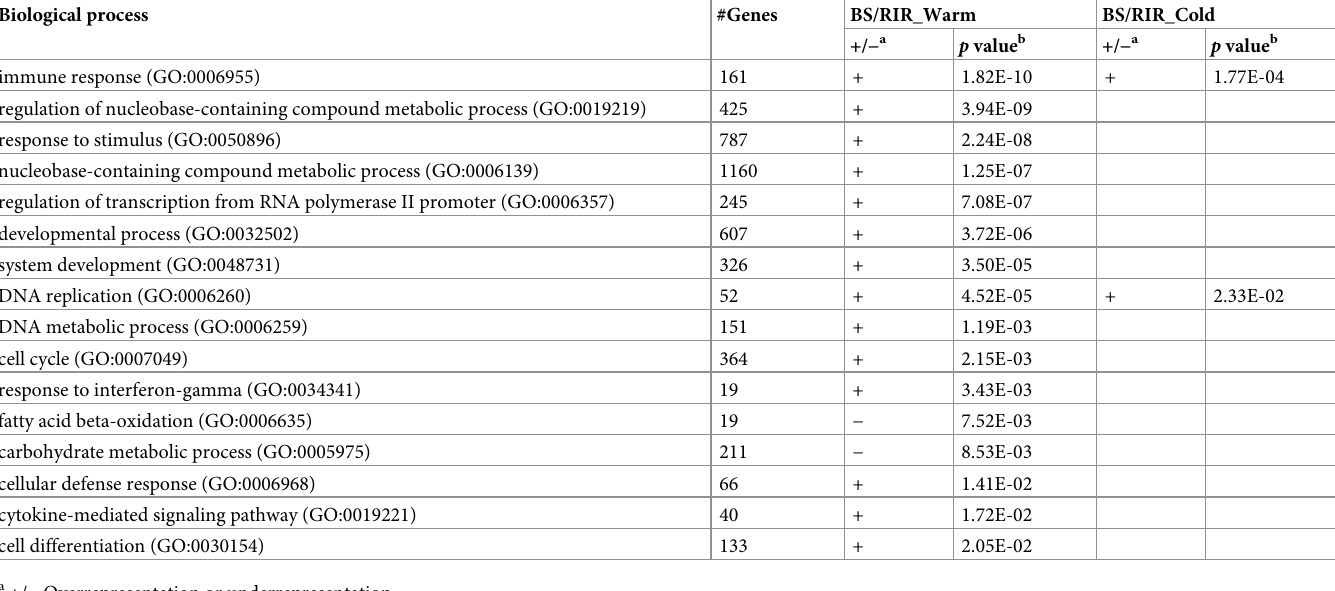
Table 5. GO enrichments for BS/RIR under cold and warm